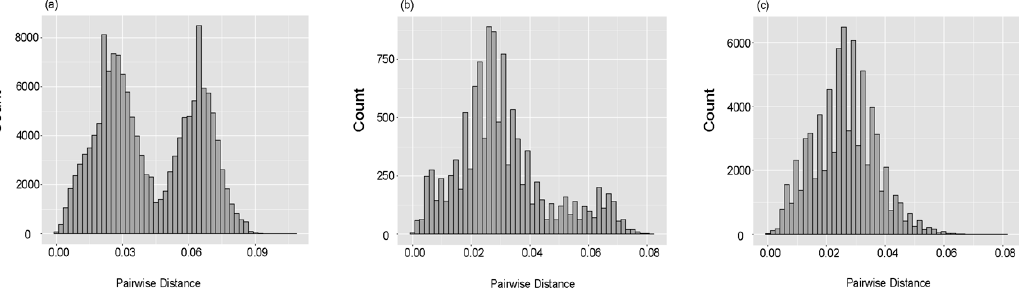
Figure 2. Distribution of nucleotide pairwise distances of RVA G1 VP7 strains: ( a ) all analyzed strains, ( b ) lineage I, ( c ) lineage II.